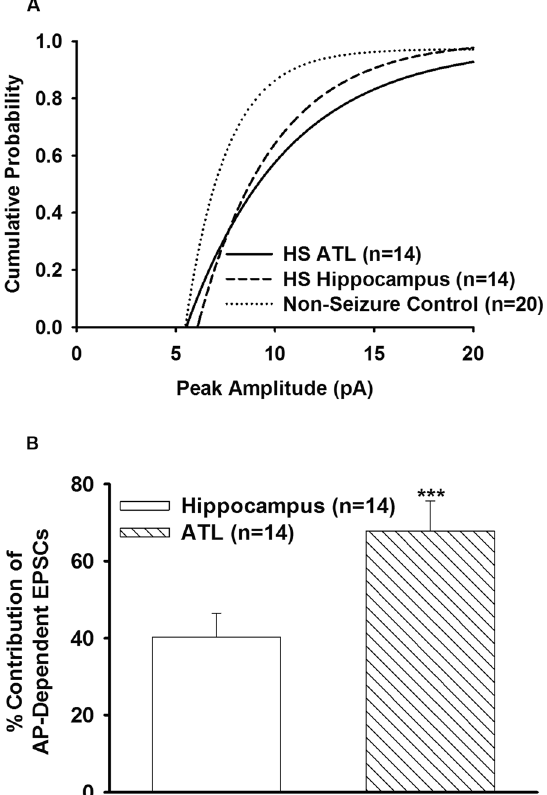
Figure 5. Contribution of action potential-dependent spontaneous EPSCs in the hippocampal and ATL samples. ( A ) Cumulative distribution of peak amplitude of mEPSCs recorded from non-epileptic control and the hippocampal and ATL samples of HS. In comparison to non-epileptic control, the cumulative distribution of peak amplitude of the hippocampal and ATL samples was displaced to the right (p = 0.03 for the hippocampal; p = 0.003 for ATL according to K-S test). ( B ) Graph shows the percent contribution of AP-dependent EPSCs in MTLE samples with respect to non-seizure control after bath application of TTX (200 nM, 10 min). Data were obtained from twenty neurons from twenty patients for non-seizure control, fourteen neurons from the hippocampal samples of fourteen HS patients and sixteen neurons from the ATL samples of fourteen HS patients. The magnitude of reduction in the frequency of spontaneous EPSCs caused by TTX in the ATL samples was significantly larger than that in case of the hippocampal samples. ( *** p = 0.0007 according to one- way ANOVA followed by Tukey post hoc